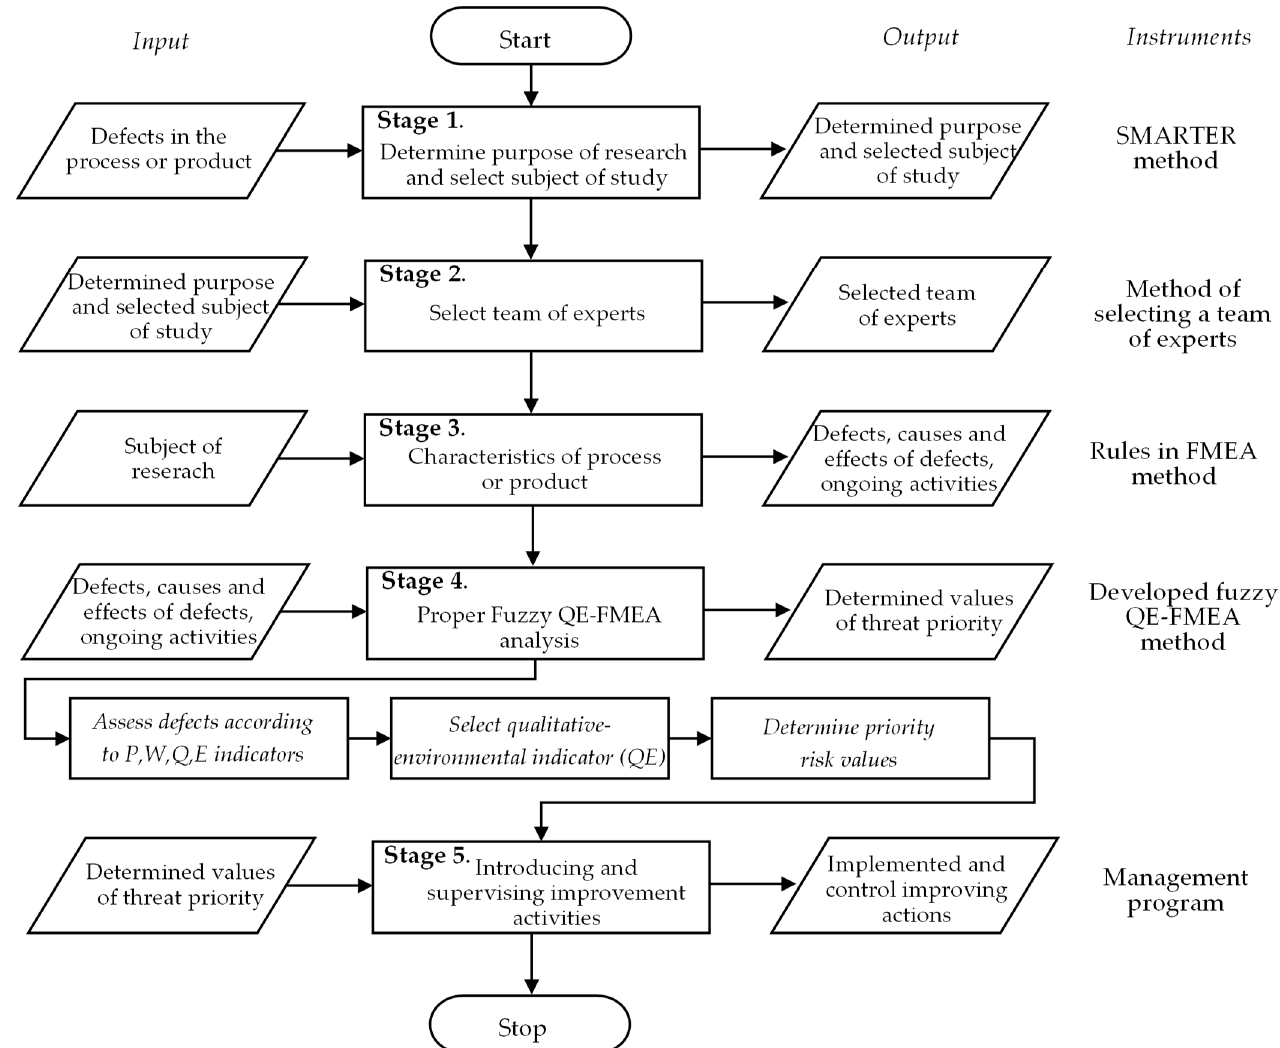
Figure 3. Algorithm of procedure of Fuzzy QE-FMEA method.